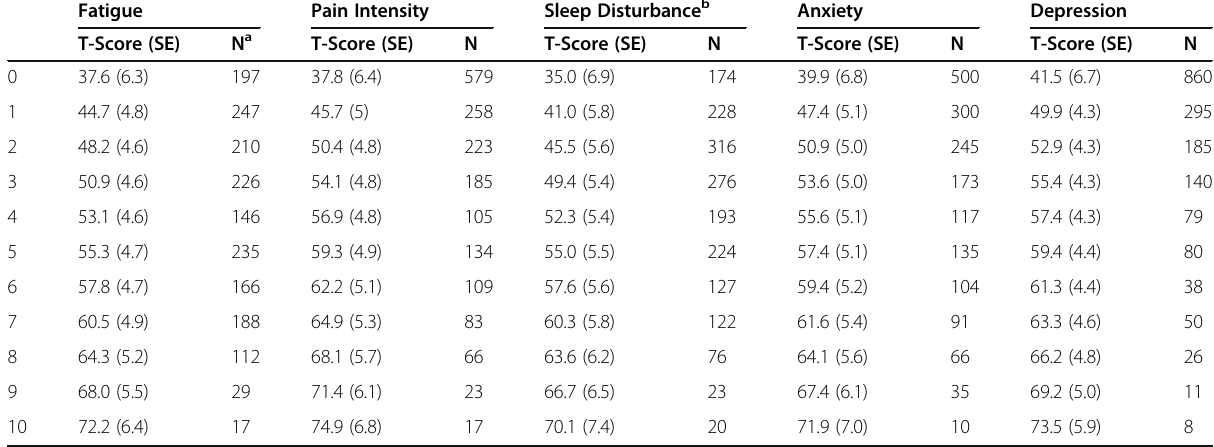
Table 3 Cross-walk Table for NRS items using Concurrent Calibration followed by Stocking-Lord Linking Constants Fatigue Pain Intensity Sleep Disturbance b Anxiety